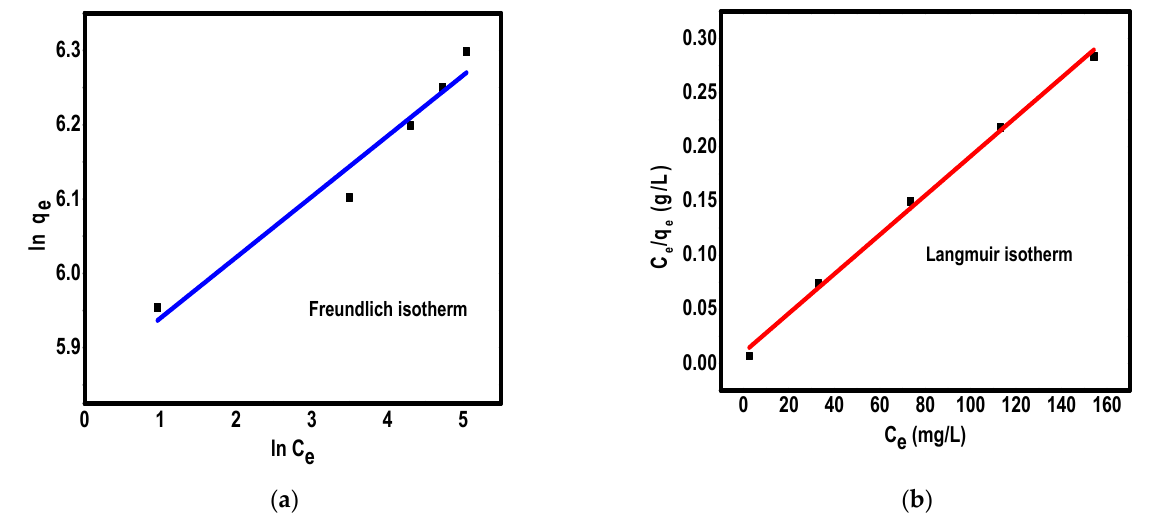
Figure 6. The fit of experimental data to Freundlich isotherm ( a ) and Langmuir isotherm ( b ) for the removal of Cr(VI) ions on the surface of ppy/NC nanocomposite. Table 2. The parameters of Freundlish and Langmuir isotherm models for the removal of Cr(VI) on the surface of ppy/NC